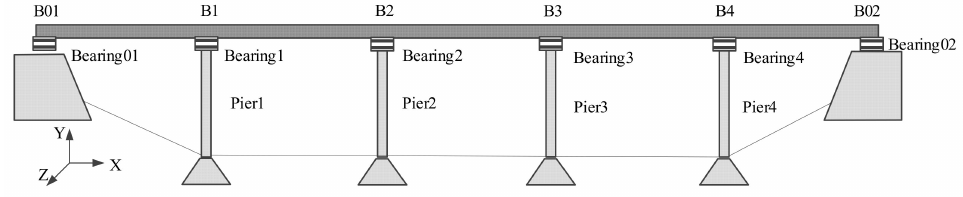
Figure 1. Analysis model of the